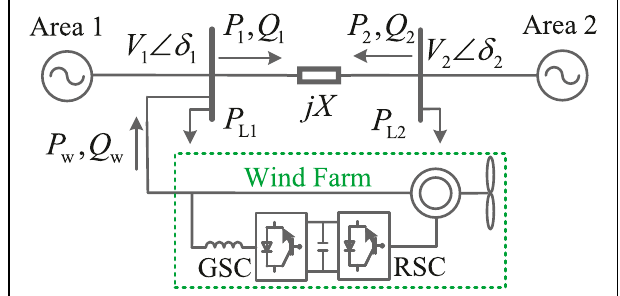
FIGURE 1 | Two-area power system integrated with the DFIG-based wind